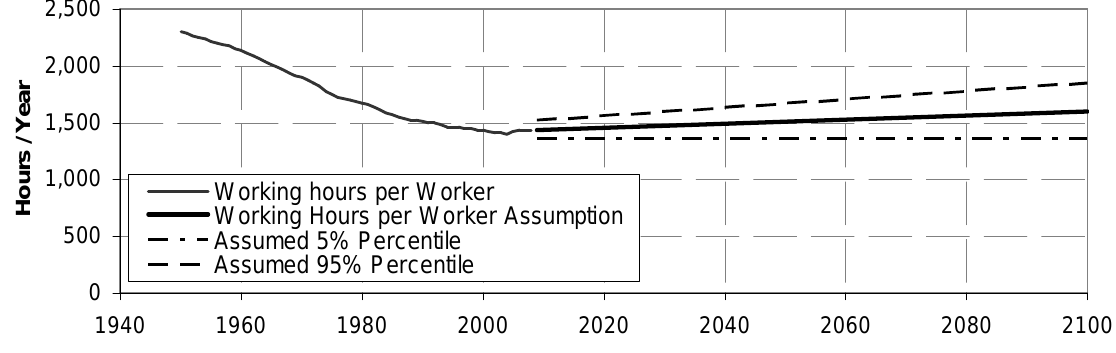
Figure 9: Assumed development of the Labour Participation in the Netherlands